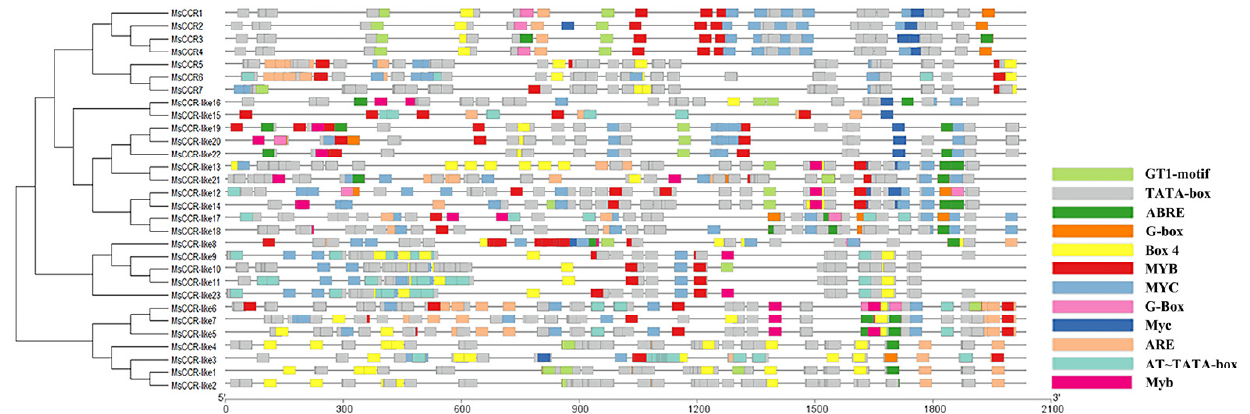
Figure 4. The putative cis -elements and transcription factor binding sites in the promoter regions of MsCCR and MsCCR-like genes. The colored blocks represent different types of cis -acting elements and their locations in each MsCCR / MsCCR-like gene.